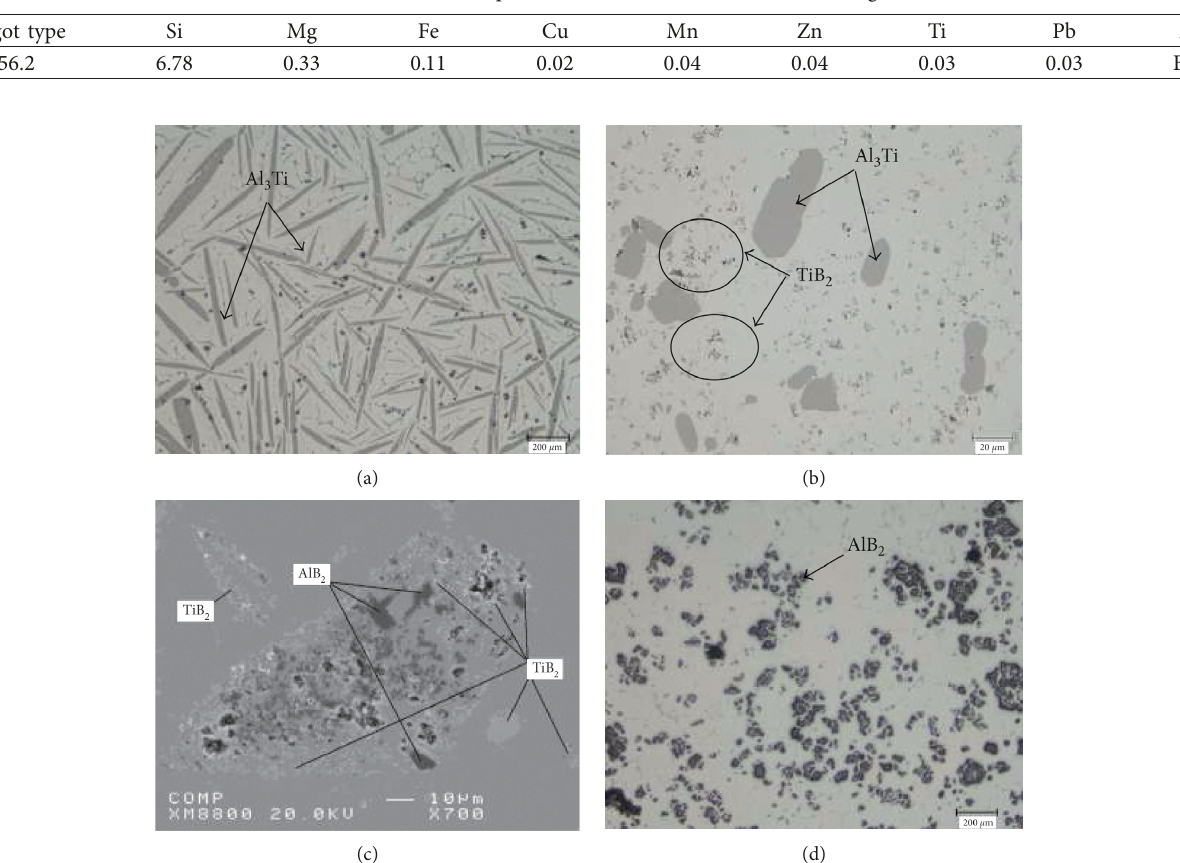
Figure 2: Optical micrographs of (a) Al-10%Ti, (b, c) Al-5%Ti-1%B, and (d) Al-4%B master alloys used in the present study.